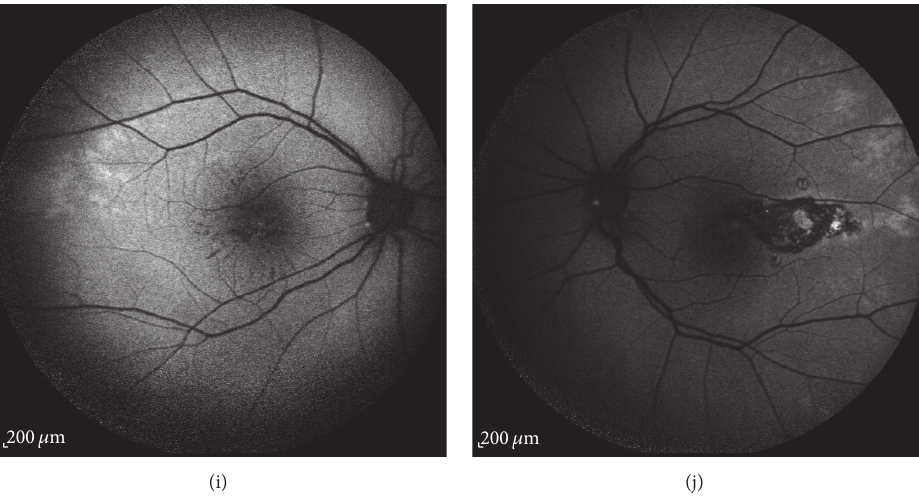
Figure 2: Patient 2. (a), (c), (e), and (g): right eye. (b), (d), (f), and (h): left eye. (a) and (b): fundus examination showing perifoveal exudates with small perifoveal capillary abnormalities on both eyes and a photocoagulation scar in the temporal area in the left eye. (c), (d), (e), and (f): fluorescein angiography (min and min) showing perifoveal telangiectasia mainly located in the superior and temporal area in the right eye and in the inferior and temporal area in the left eye with late intraretinal staining. (g) and (h): spectral-domain optical coherence tomography (B- scan) showing cystoid macular edema on both eyes with subretinal fluid in the right eye with a central macular thickness measured to 538 𝜇 m on the right eye and to 334 𝜇 m on the left eye. (i) and (j): autofluorescence images revealed in RE some hypoautofluorescent lesions in the temporal and inferior macular area, with a stellar distribution corresponding to the exudates. In the LE, the autofluorescence images revealed a large hypoautofluorescent lesion in the temporal area coexisting with smaller ones in the inferior area corresponding to photocoagulation